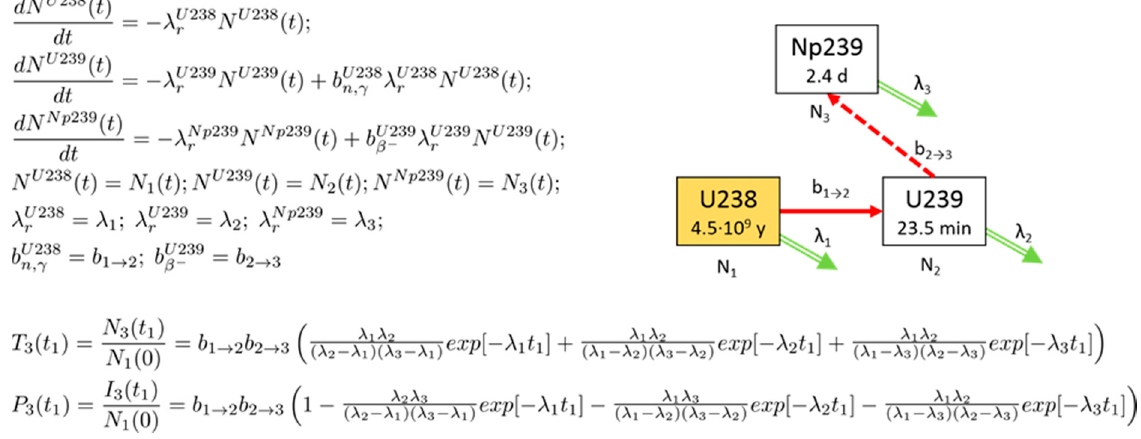
Figure 5. Third transmutation trajectory in the 238 U chain.